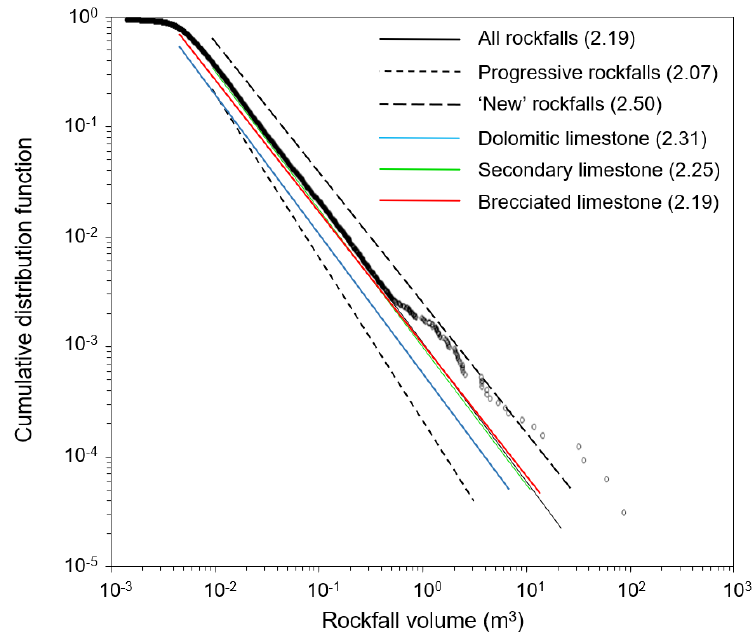
Figure 5. Cumulative distribution functions (CDF) and associated power law functions for the entire rockfall inventory, progressive and ‘new’ rockfalls, and specific lithologies. Scaling exponents for each inventory are displayed in brackets. CDFs were derived and plotted using the ‘poweRlaw’ toolbox for R (https://cran.r-project.org/web/packages/poweRlaw/index.html).